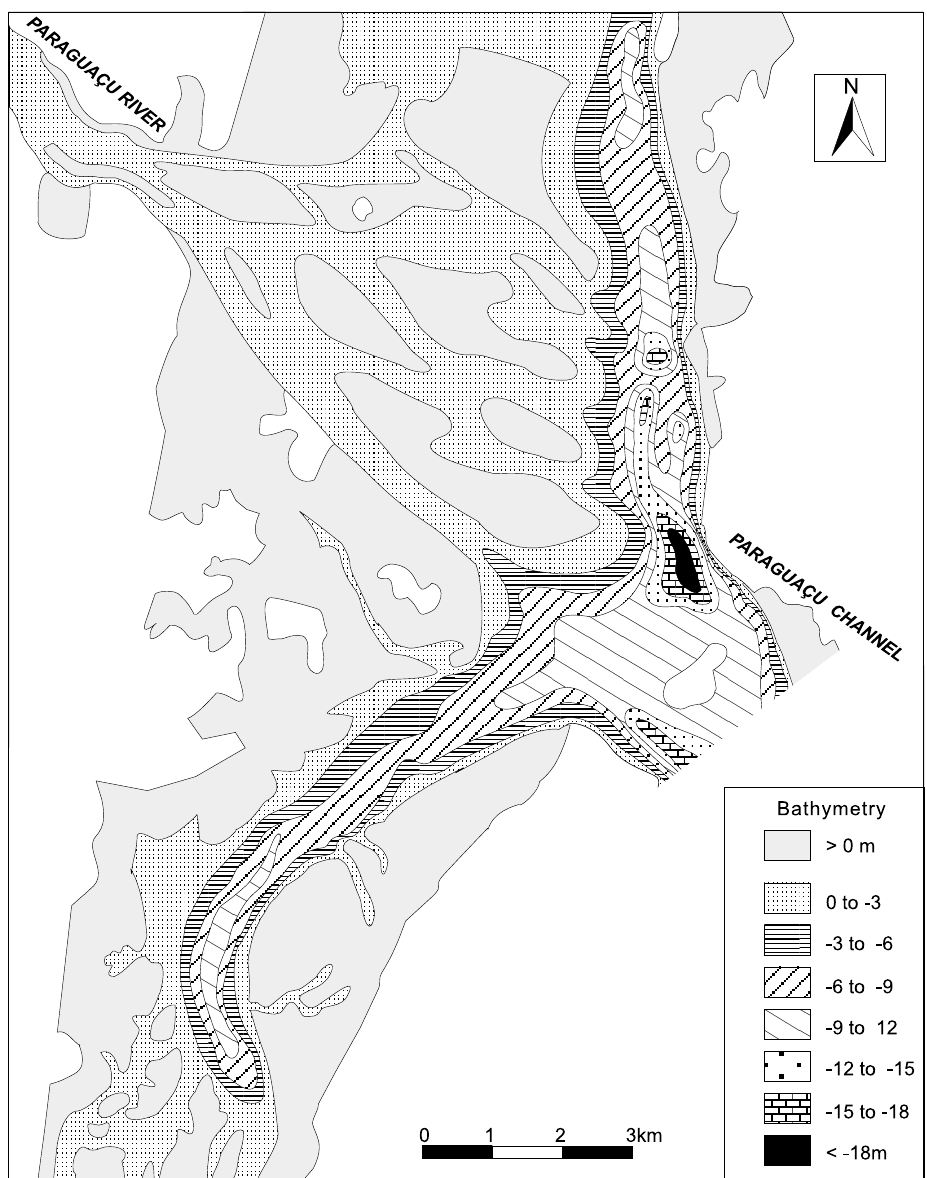
Fig. 3 – General bathymetry of Iguape Bay. The isobath of 0 m refers to low water level (after Avanzo